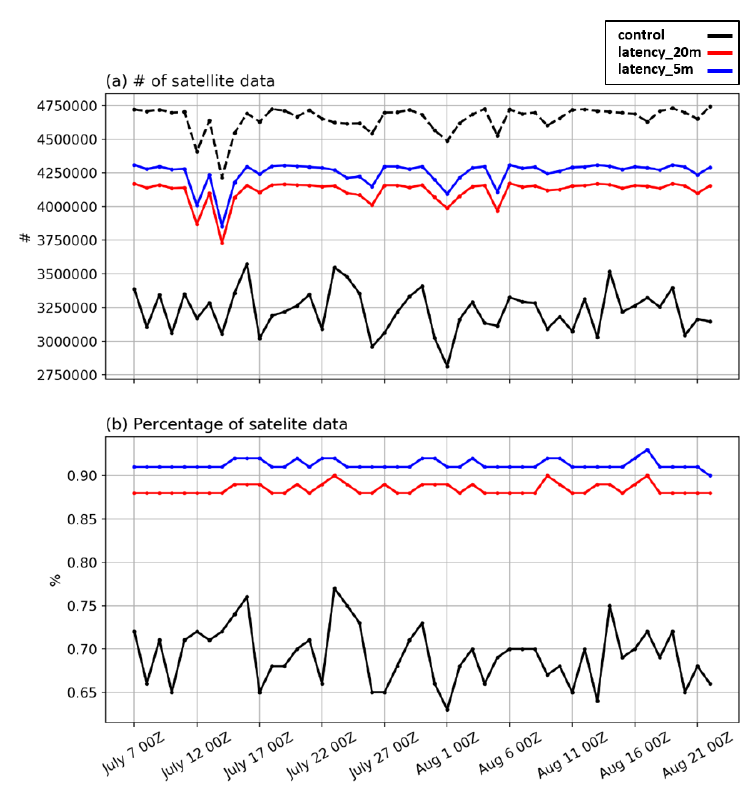
Figure 2. Time series of ( a ) total number of the hyperspectral infrared (IR) and microwave (MW) sounder measurements available at the GFS run for the control (black solid), latency_20m (red solid), and latency_5m (blue solid) runs, and ( b ) observation percentage (%) normalized against the number of the sounder measurements used for the GDAS run. The black dashed line indicates the number of the sounder measurements available for the GDAS run.